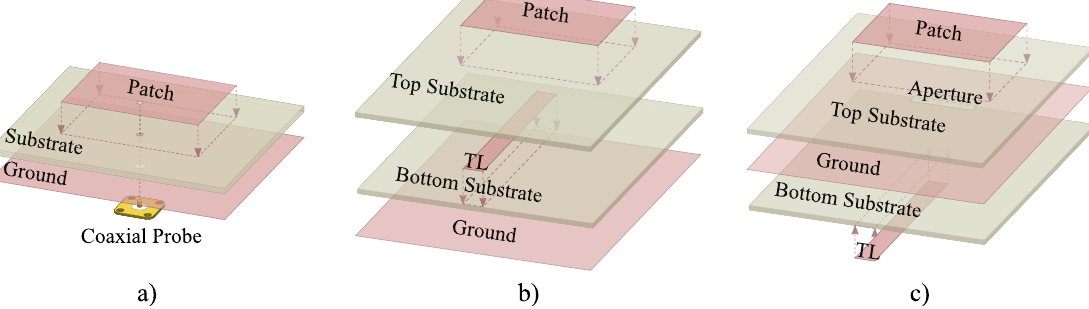
Figure 1. ( a ) Coaxially fed microstrip antenna. ( b ) Electromagnetically coupled microstrip antenna. ( c ) Aperture-coupled microstrip